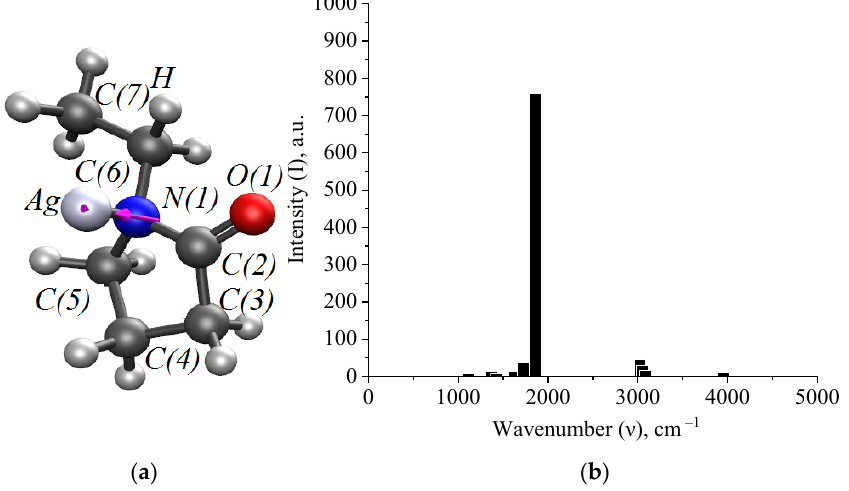
Figure 9. Modeling of spectral characteristics of Ag ‐ PVP molecular complex (interaction through nitrogen): ( a )—the oscillation of the N ‐ Ag bond and ( b )—the IR spectrum.